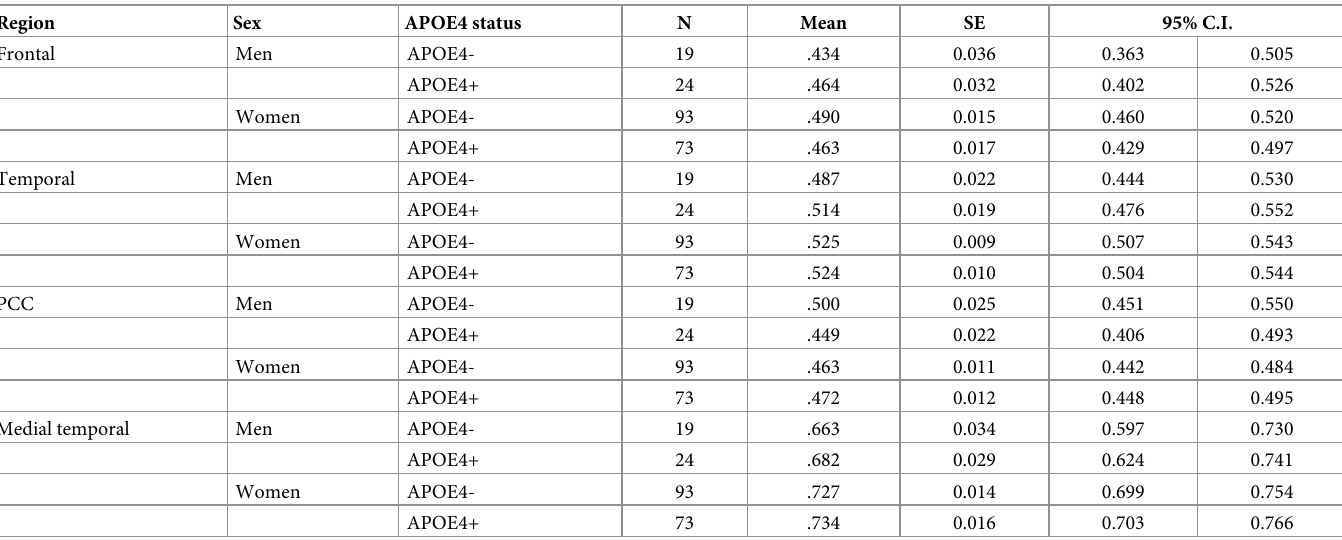
Table 4. Regional Pi/ATP by sex and APOE4